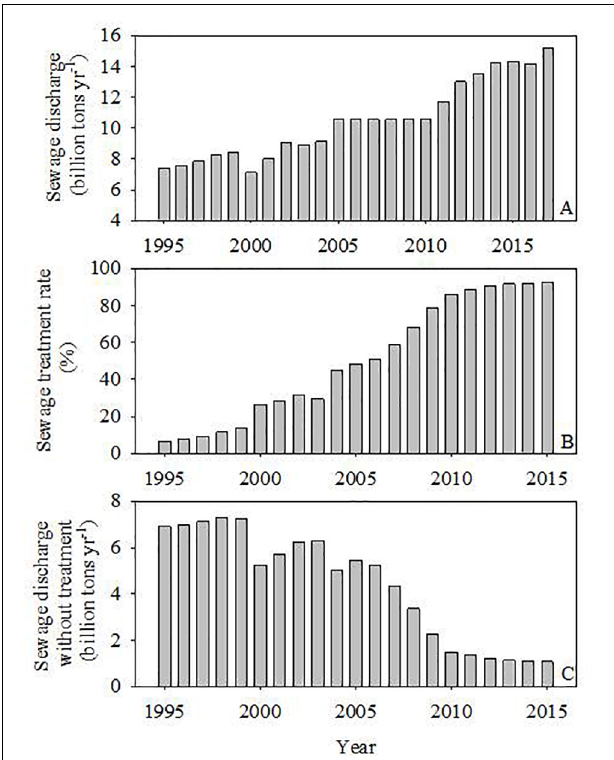
FIGURE 3 | Urban sewage discharges, sewage treatment rate, and sewage discharges without treatment from the city Guangzhou. Each column represents one year. Data were from the Bulletin of Statistics of Guangzhou’s Environmental Status (1995–2015),